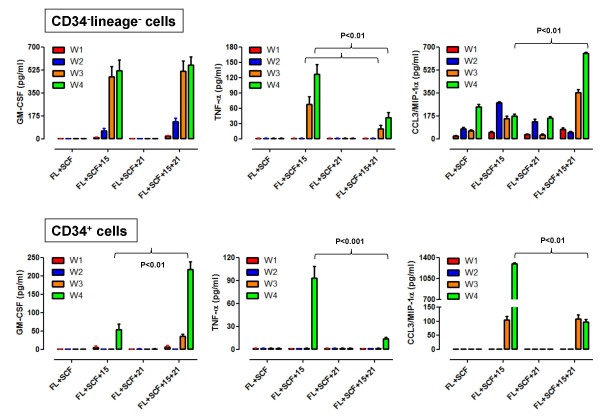
Cytokine and chemokine release from CD34-lineage- cells and CD34+ cells differentiated with IL-15 and IL-21. The production of GM-CSF, TNF-α and CCL3/MIP-1α in supernatants of CD34-lineage- cells and CD34+ cells maintained with SCF+Flt3-L either alone or supplemented with IL-15, IL-21 or the combination of both cytokines was monitored weekly with conventional ELISA. Bars depict mean and standard deviation recorded in 3 independent experiments performed in triplicate. FL = Flt3-L; W = week.